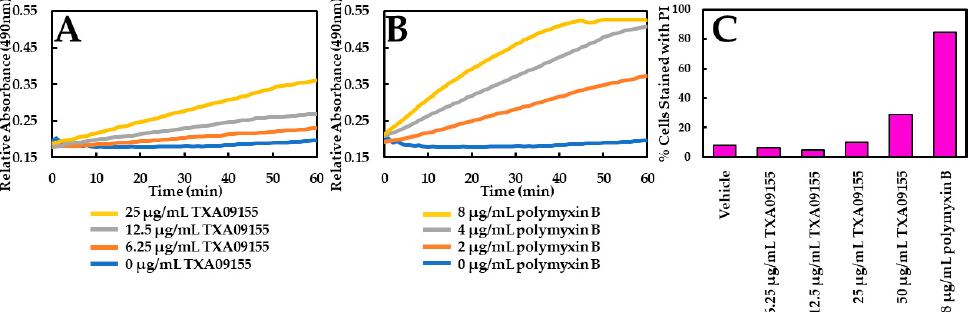
Figure 2. Outer- and inner-membrane permeabilization studies with TXA09155. Basal levels of NCF hydrolysis ( A , B ) or PI fluorescence ( C ) are observed upon addition of TXA09155 at concentrations below 12.5 and 50 µg/mL, respectively, indicating intact outer and inner membranes. Experiments were repeated at least three times, and a representative experiment is shown.